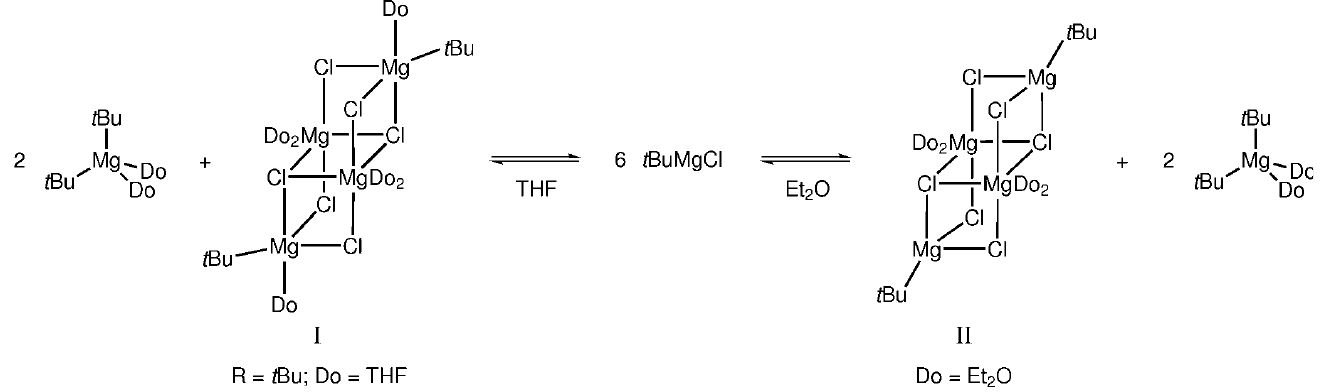
Figure 2 Open-cube structures like I ( R = t Bu) are obtained by crystallization of t BuMgCl from THF solutions, whereas the less-solvated title compound II crystallizes from Et 2 O solutions of t BuMgCl.